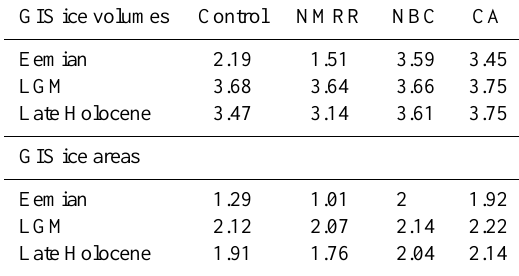
Table 3. Final GIS ice volumes ( / 10 6 km 3 ) and areas ( / 10 6 km 2 ) for all equilibrium experiments. NMRR=no melting/refreezing; NBC=no bias correction; CA=constant